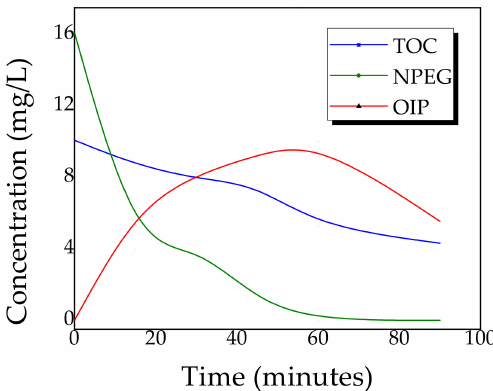
Figure 5. Reaction behavior: total organic carbon (TOC) represents the total organic carbon of the mineralization of the NPEG; NPEG = 20 mg / L, measured by UV spectroscopy; organic intermediate products (OIPs) = obtained by mass